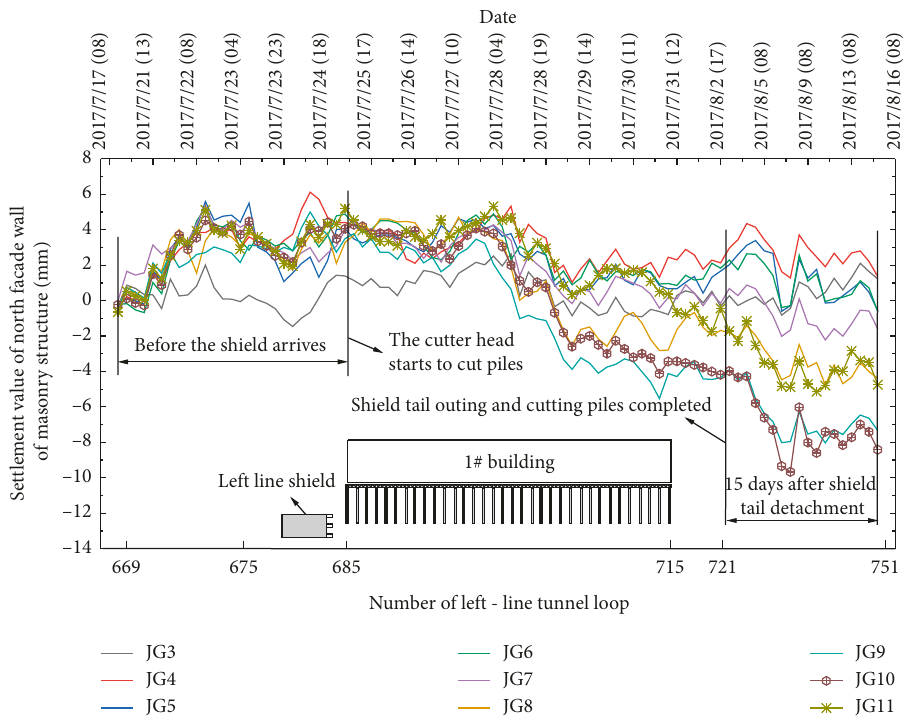
Figure 11: Settlement time-history curve of north facade wall of the JG17 and JG16 on the south wall were -8.66 mm and South Wall have settlement variation ranges of -10.98 mm, respectively, and the settlement values of the +3.49 mm ∼ − 5.79 mm, +4.3 mm ∼ − 2.53 mm, respec- measuring points JG10 and JG11 on the north wall were tively. 15 days after the shield tail of the left line was − 9.63 mm and − 7.76 mm, respectively. protruded, the settlement values of the measuring points